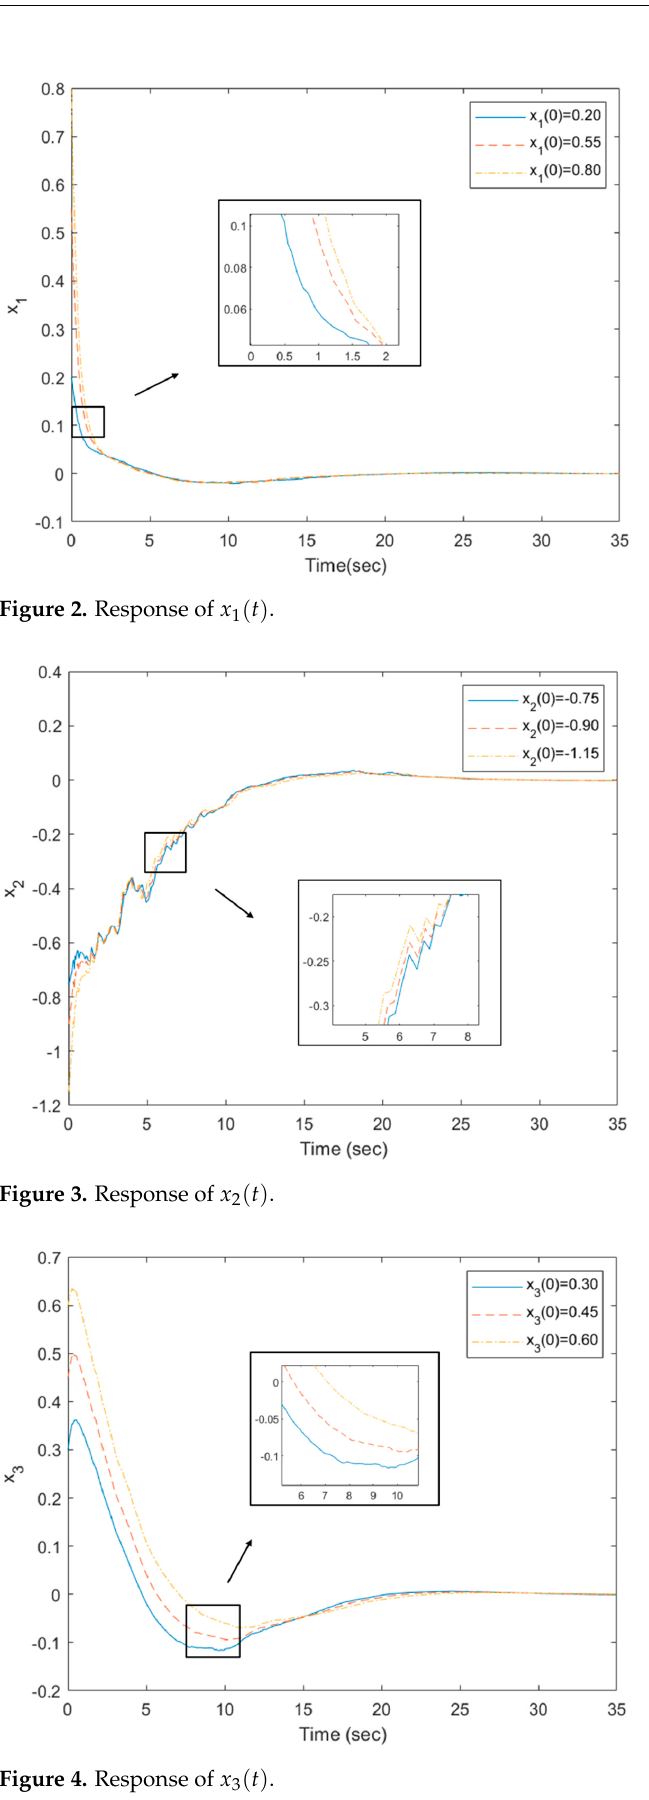
Figure 4. Response of x 3 ( t )